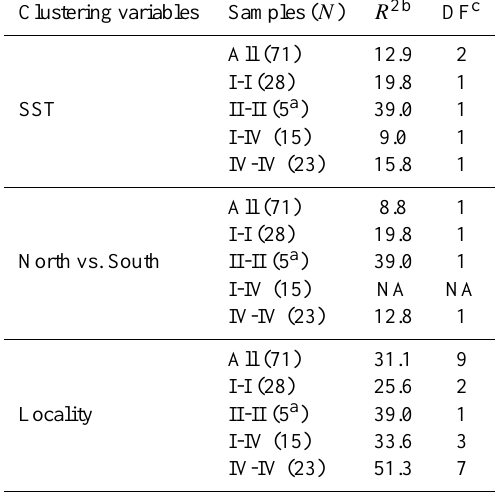
N : sample size. a small sample size. b R 2 indicates the proportion (%) of variability accounted for by the clustering variable. c DF is the number of free parameters in the